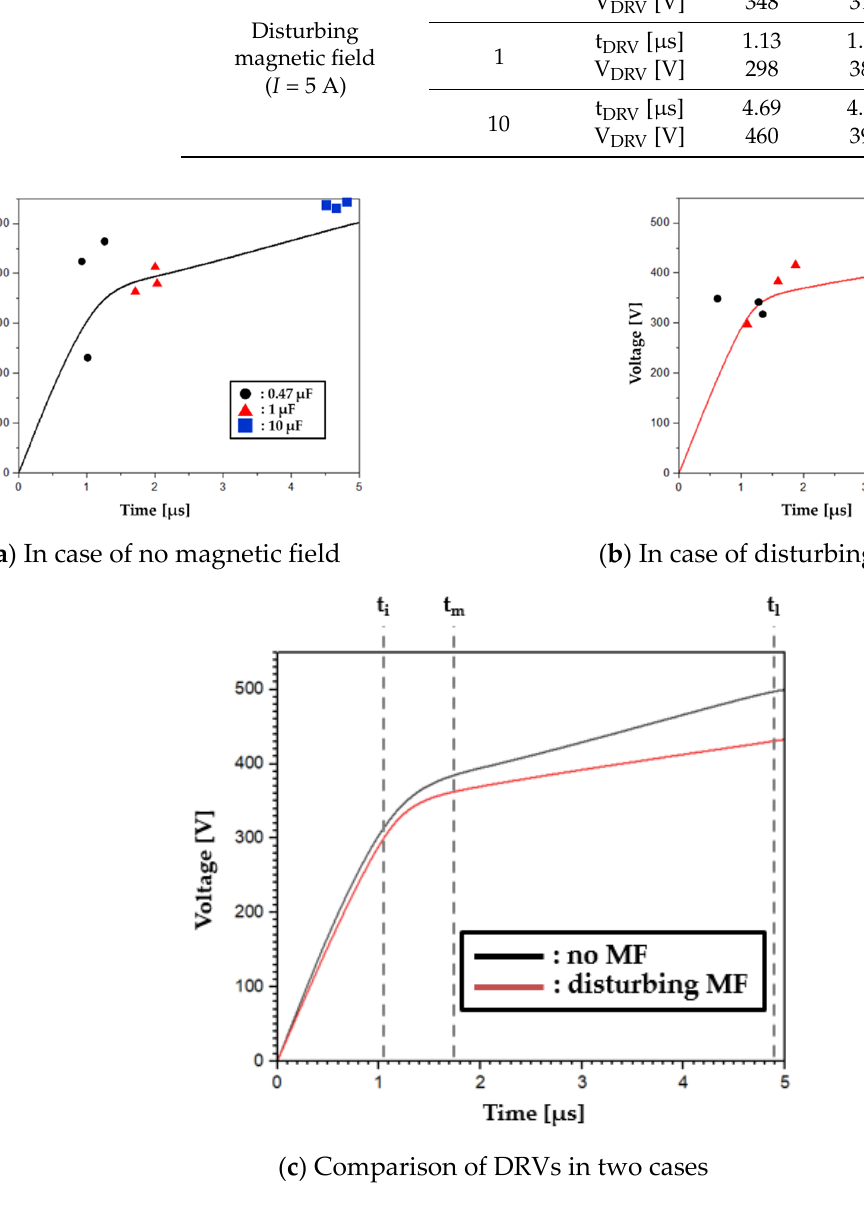
Figure 17. DRV V-t curve under disturbed magnetic fields.